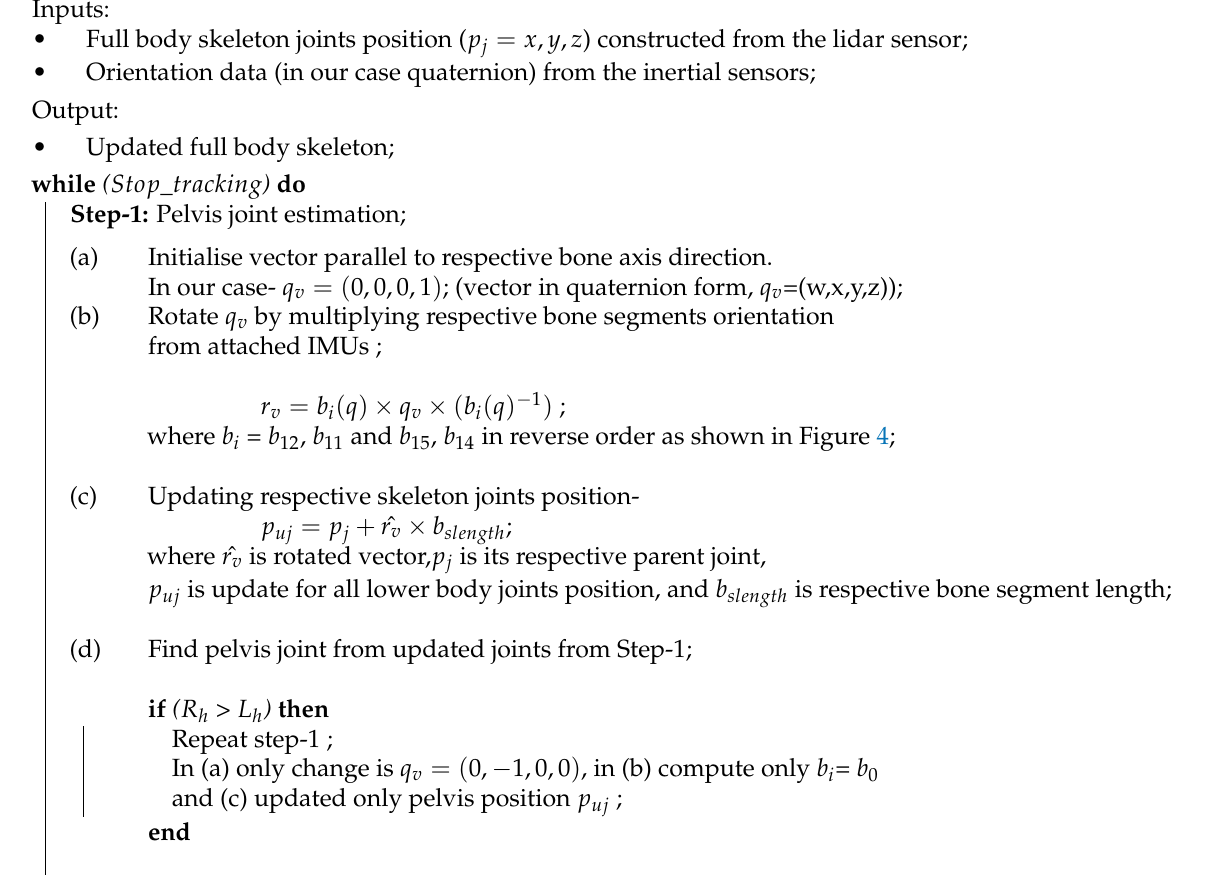
Algorithm 1: Vector-based position and orientation estimation in